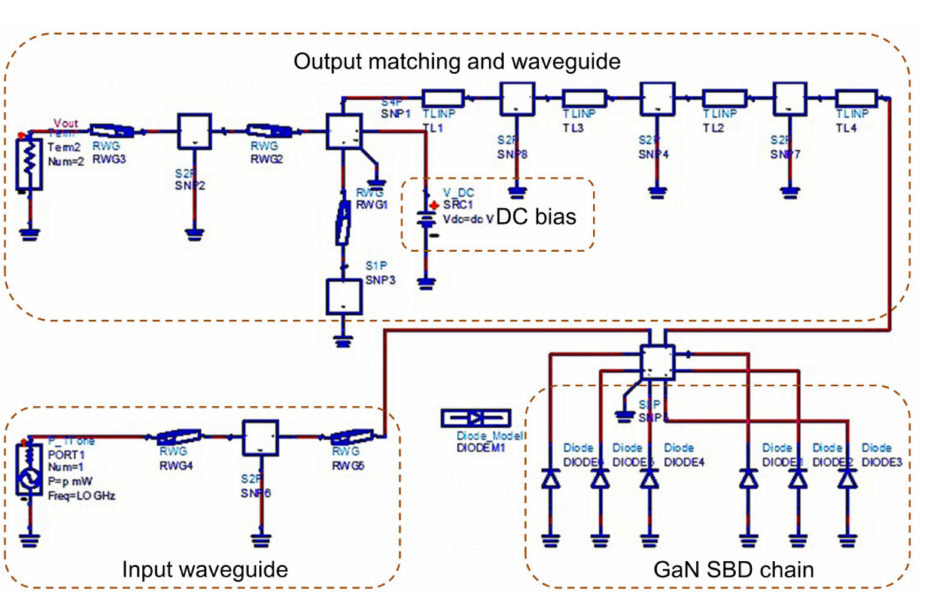
Figure 5. Design of the 120 GHz monolithic integrated doubler.